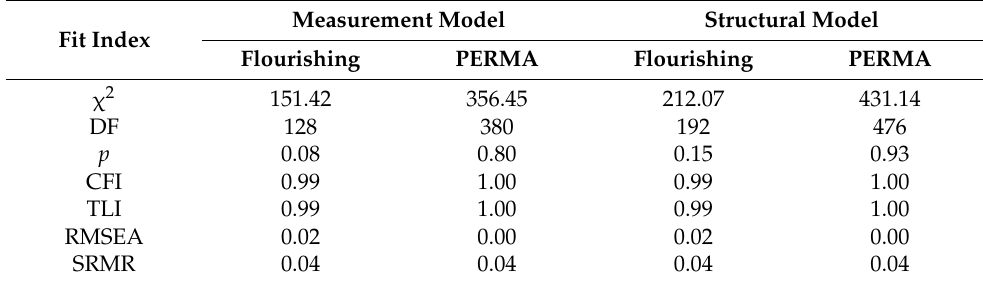
Table 2. Goodness-of-fit Indices of the Measurement Model and Structural Model.